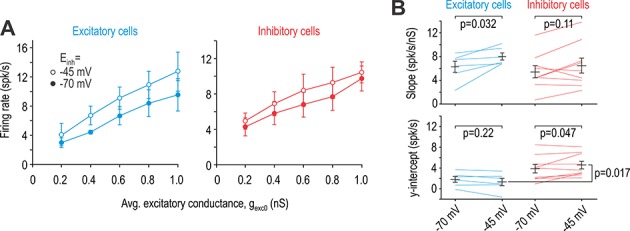
Effects of virtual disinhibition for α = 0.5 (virtual stimulation in RF centre).(A) Average i-o curves (± sem) for excitatory neurons (blue) and inhibitory neurons (red). (B) Einh had a significant effect on slope (F1,13 = 8.82, p=0.011, two-way repeated measures ANOVA) but only in excitatory cells. Results of SNK tests are reported on graphs. The effect of Einh on the y-intercept differed significantly between excitatory and inhibitory cells (interaction, F1,13 = 5.67, p=0.033), with only inhibitory cells experiencing a significant change. Like for virtual stimulation in the RF surround (Figure 6), the y-intercept differed significantly (p=0.017; SNK test) between excitatory and inhibitory cells for Einh = −45 mV.